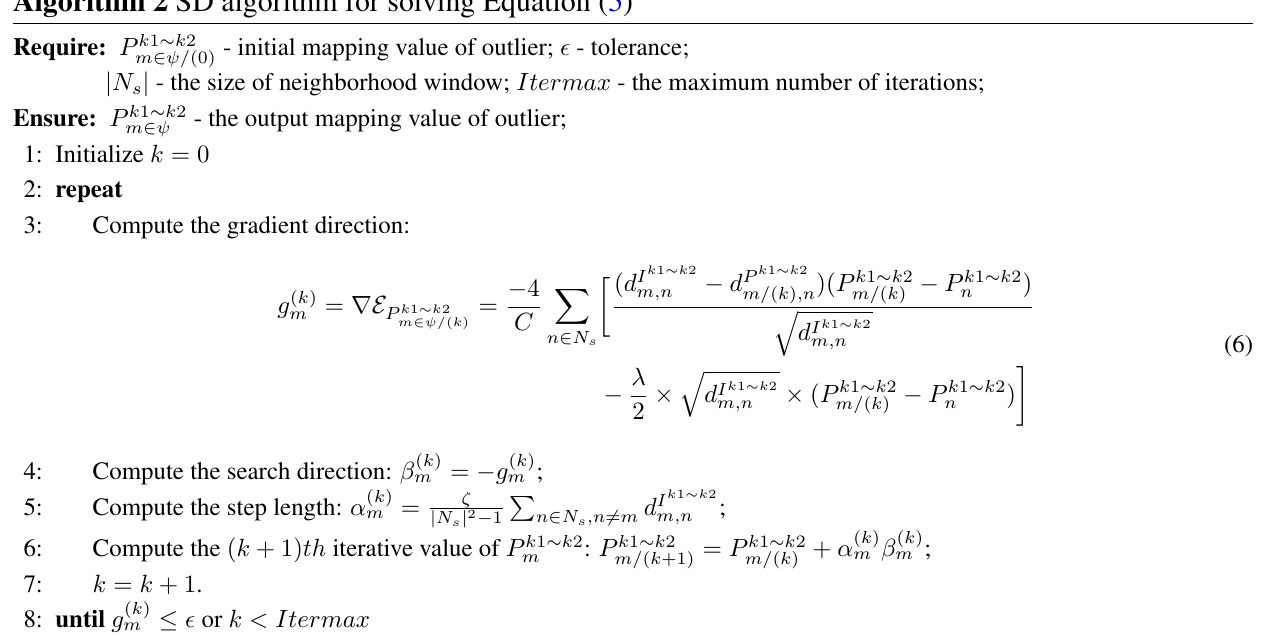
Algorithm 2 SD algorithm for solving Equation